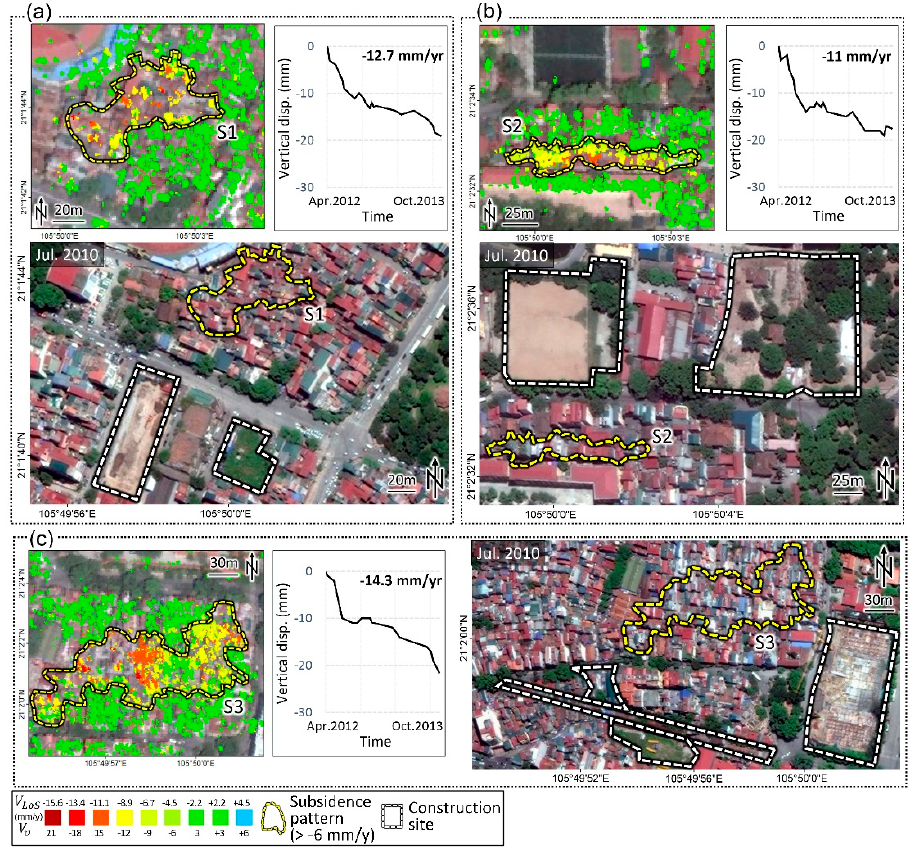
Figure 6 . Average for April 2012–November 2013. LoS velocity map, temporal evolution chart and optical image represent location of subsidence pattern and construction sites in ( a ) Hang Chao (S1), ( b ) Thuy Khue (S2) and ( c ) Le Hong Phong (S3). Characters in parentheses denote the label of subsidence patterns in Figure 4.